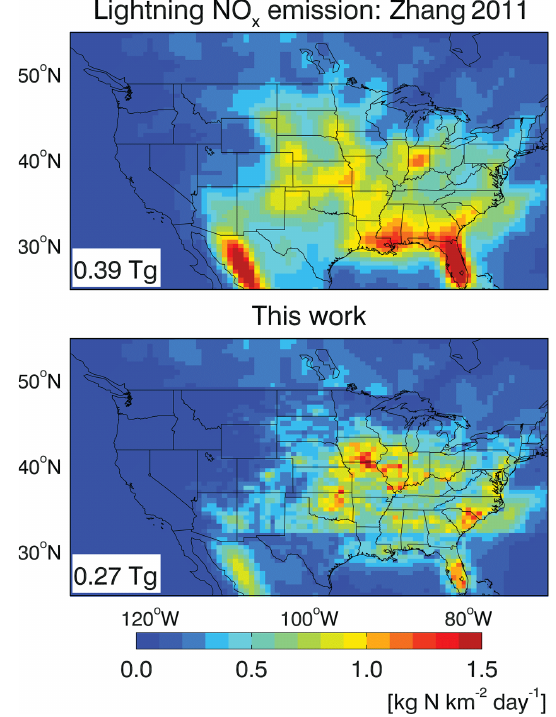
Figure 1. Mean NO x emissions from lightning in summer (June– August) 2006–2008. Values from Zhang et al. (2011) are compared to the improved simulation in this work. The numbers inset indicate the mean summer total lightning emissions (TgN) over the contigu- ous